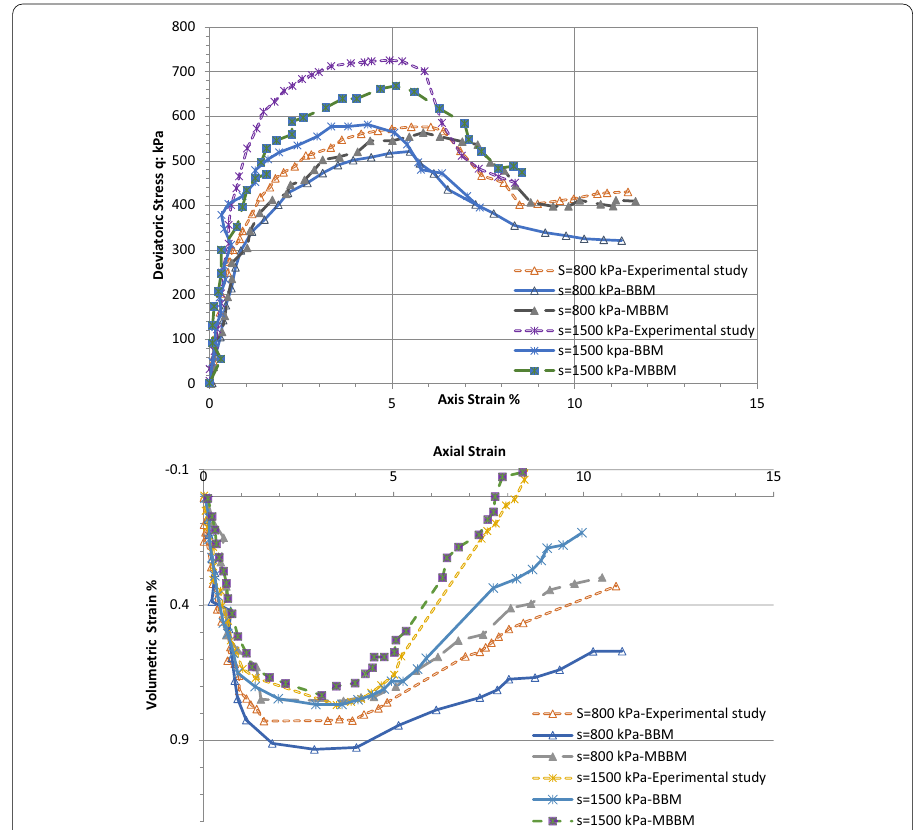
Fig. 19 Comparative curves among experimental, BBM and MBBM for stress–strain and volume change at confining pressure 50